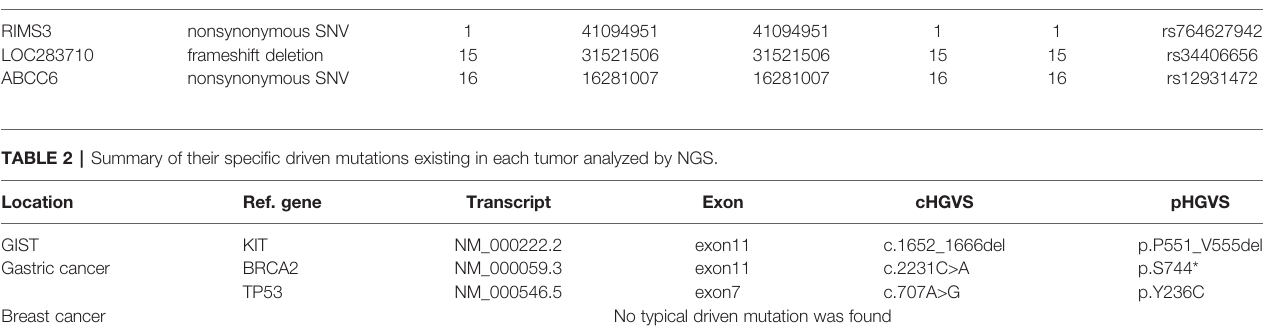
TABLE 1 | Summary of the similar somatic mutations existing in each tumor analyzed by NGS. Ref. gene